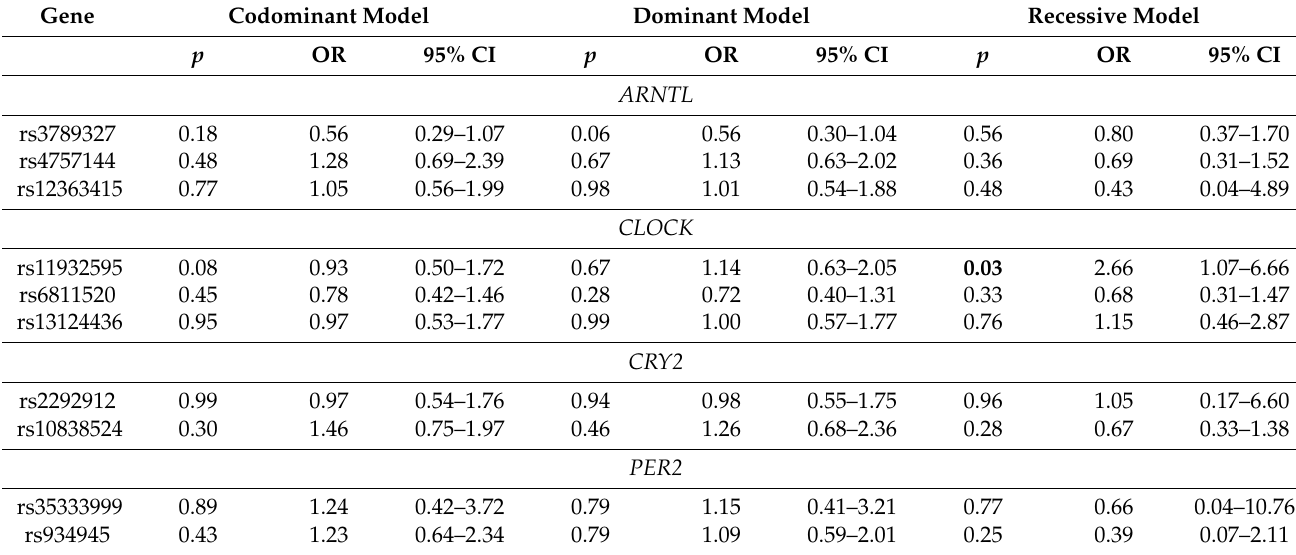
Table 2. Genotype models of the ARNTL , CLOCK , CRY2, and PER2 polymorphisms. Gene Codominant Model Dominant Model Recessive Model